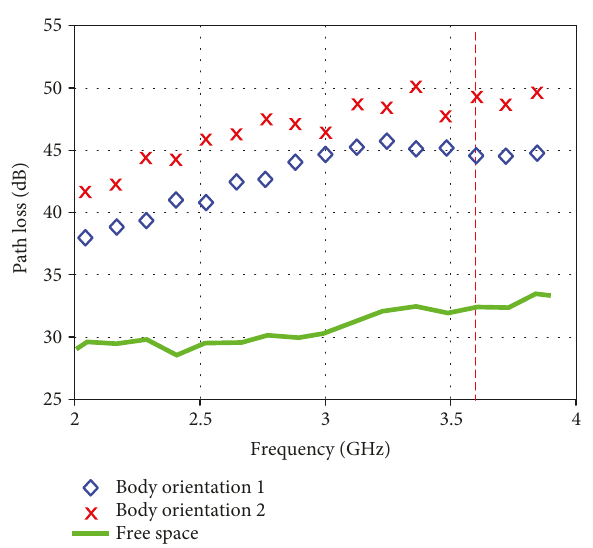
Figure 4: Results of body shadowing measurements as a function of frequency. The 3.6GHz frequency is marked with a red dotted